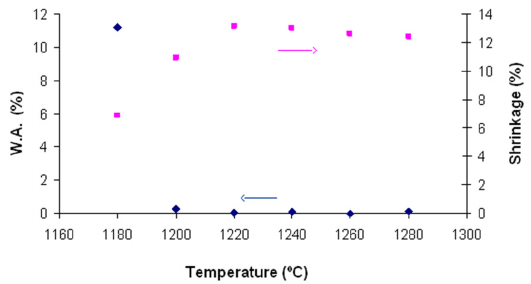
Figure 2. Linear shrinkage and water absorption (W.A.) as a function of firing temperature. Spodumene